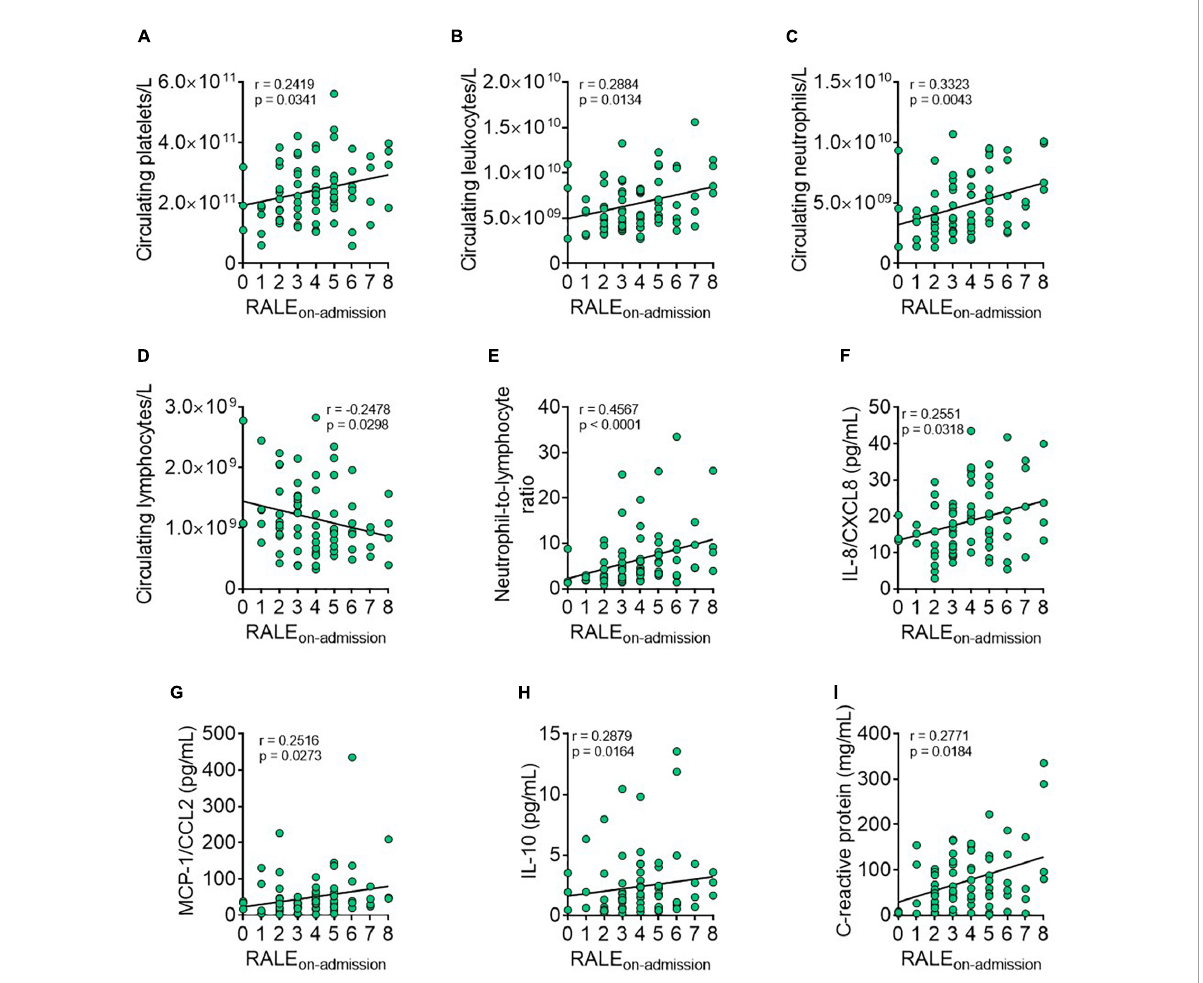
FIGURE1 The radiographic assessment of lung edema (RALE) score correlates with several admission hemogram and inflammatory parameters in patients with coronavirus disease 2019 (COVID-19). Correlations between admission hemogram parameters [number of circulating platelets/L, (A) leukocytes/L, (B) neutrophils/L, (C) lymphocytes/L, (D) and neutrophil-to-lymphocyte ratio, (E) ] or plasma levels of inflammatory mediators [IL-8/CXCL8, (F) monocyte chemoattractant protein-1 (MCP-1/CCL2), (G) IL-10, (H) , and C-reactive protein, (I) ] and the RALE score